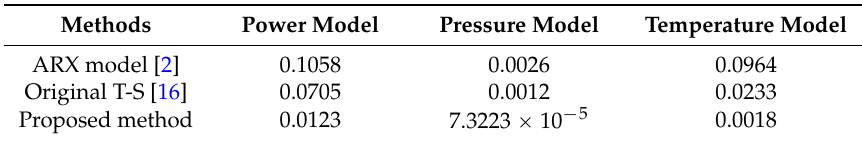
Table 3. MSE of different methods for different